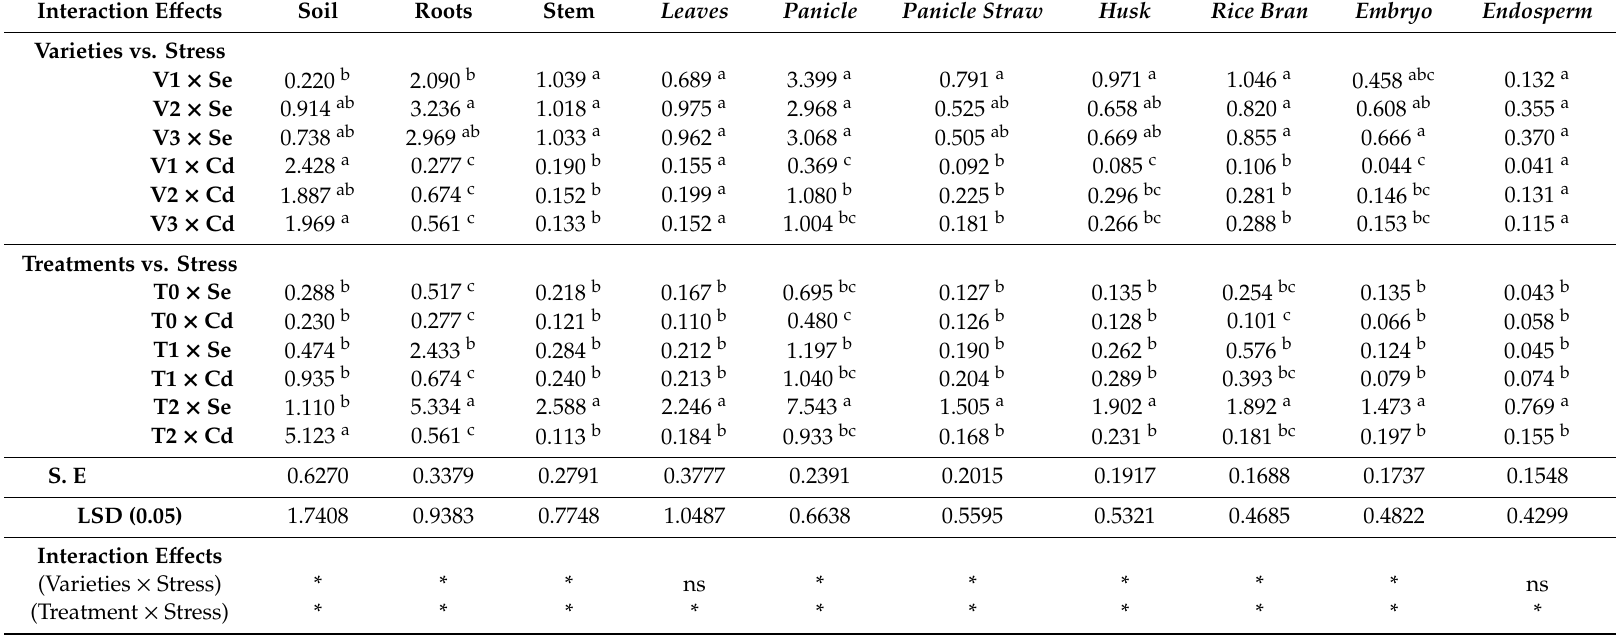
Table 3. Two-factor factorial analysis design (varieties × stress, treatment × stress interaction e ff ects all pairwise possible combinations). Interaction E ff ects Soil Roots Stem Leaves Panicle Panicle Straw Husk Rice Bran Embryo Endosperm Varieties vs. Stress